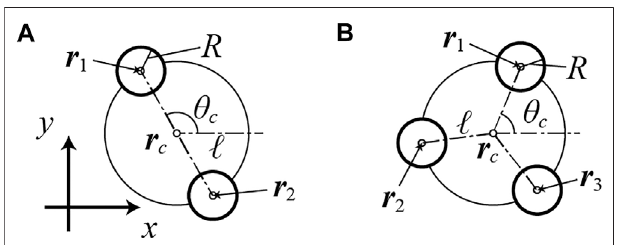
FIGURE 1 | Schematic illustration for the camphor fl oat with n -fold rotational symmetry. (A) n = 2. (B) n =